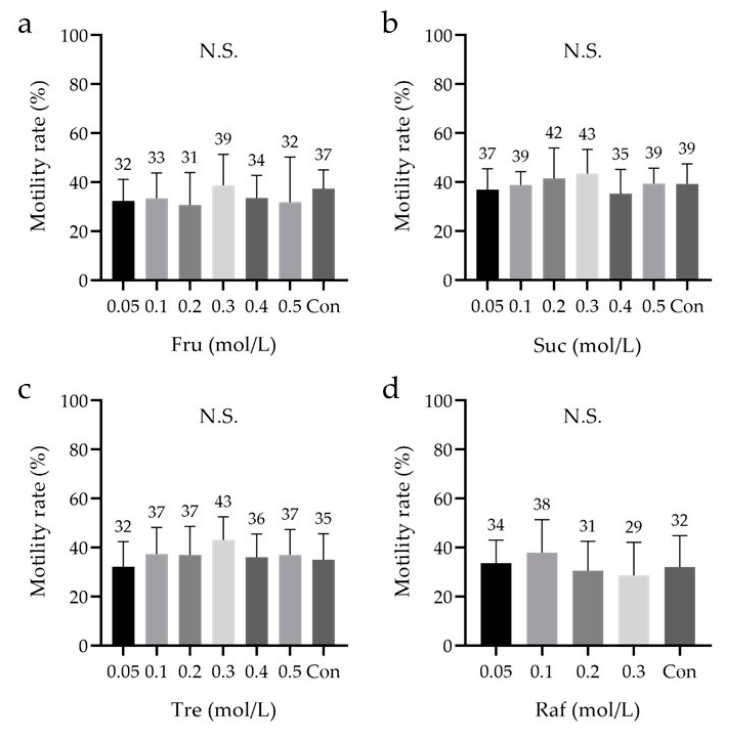
Figure 4. Sperm motility rate after freeze–thawing with cryopreservation reagents containing sac- charides at different concentrations. ( a ). Fructose (Fru), 0.05–0.5 M. ( b ) Sucrose (Suc), 0.05–0.5 M. ( c ) Trehalose (Tre), 0.05–0.5 M. ( d ) Raffinose (Raf), 0.05–0.3 M. ( a – d ) The low-Mw CPA was 7% v / v glycerol (Glyc), and the macro-Mw CPA was 0.3% w / v carboxylated poly- L -lysine (CPLL). The cry-